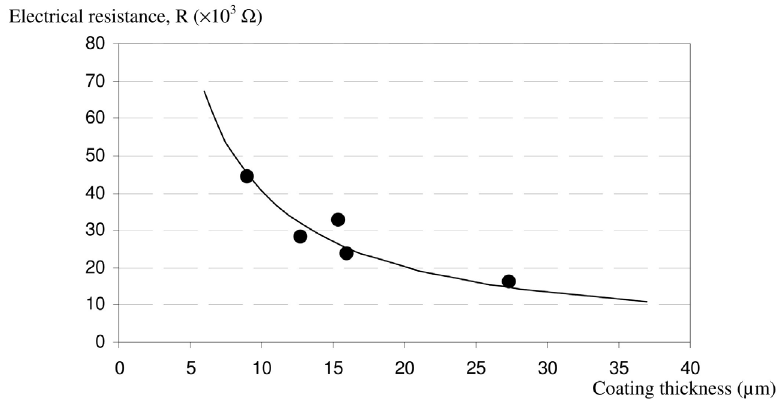
Figure 3. Electrical resistance vs. thickness of coated track.